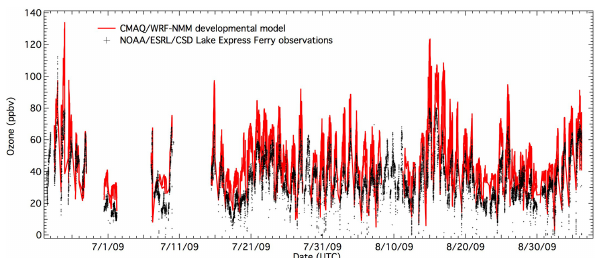
Figure 9. Graph of all CMAQ model forecast ozone mixing ratios in red with Lake Express Ferry observations in black from 2009.